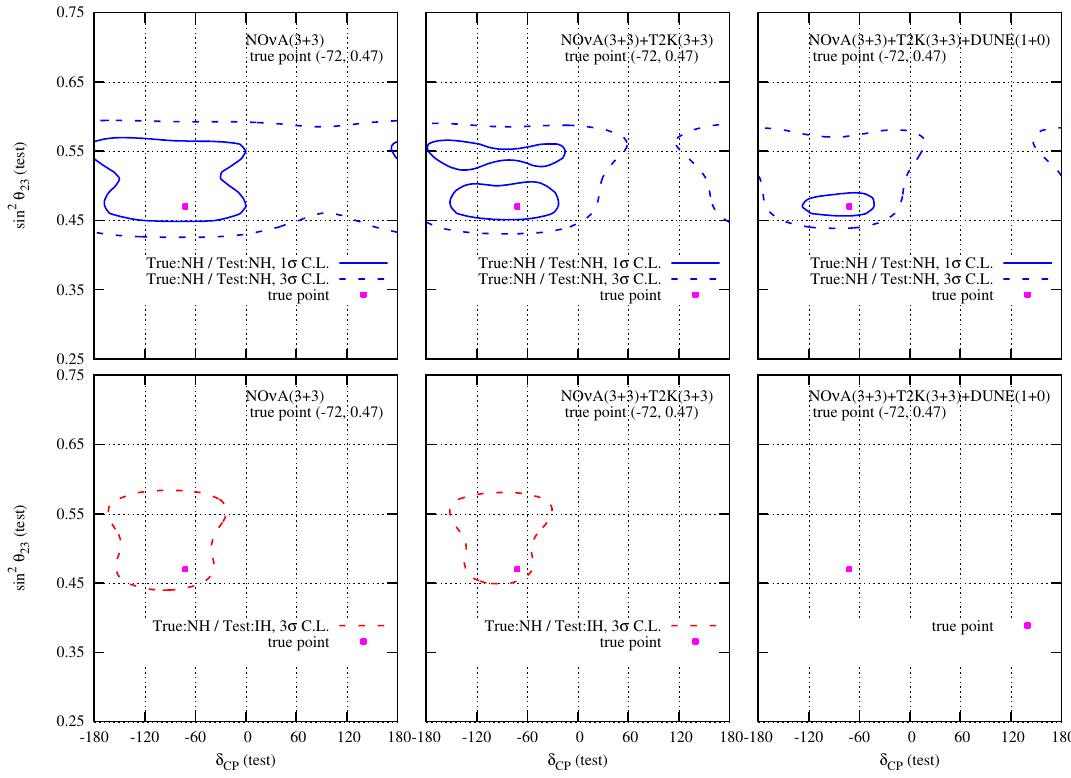
Figure 4 . Allowed regions in sin 2 (cid:18) 23 (cid:0) (cid:14) cp parameter space assuming the LO solution is correct. The left, middle and right columns are for NO (cid:23) A (3 (cid:23) +3(cid:22) (cid:23) ), NO (cid:23) A (3 (cid:23) +3(cid:22) (cid:23) ) + T2K (3 (cid:23) +3(cid:22) (cid:23) ) and NO (cid:23) A (3 (cid:23) +3(cid:22) (cid:23) ) + T2K (3 (cid:23) +3(cid:22) (cid:23) ) + DUNE (1 (cid:23) ) respectively. The top (bottom) row is for test NH (IH). between the two octants. T2K data strongly discriminates against (cid:14)